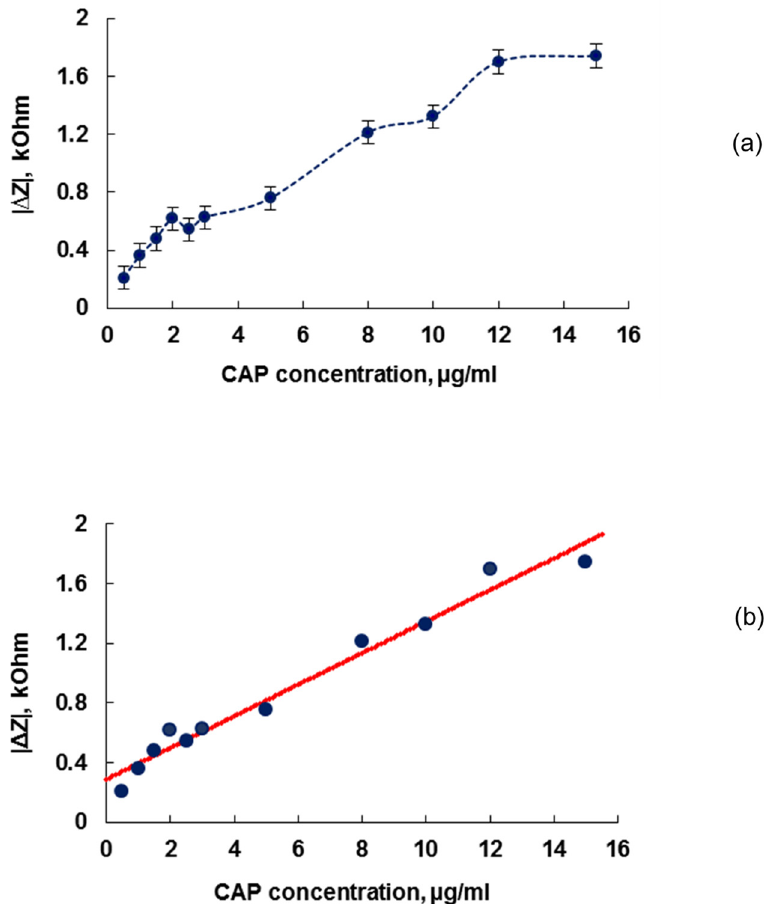
Figure 5. The dependence of the absolute value of the change in the electrical impedance modulus | ∆ Z | on the CAP concentration added to E. coli K-12 cells at a frequency of 6.65 MHz without ( a ) and with ( b ) the calibration curve.